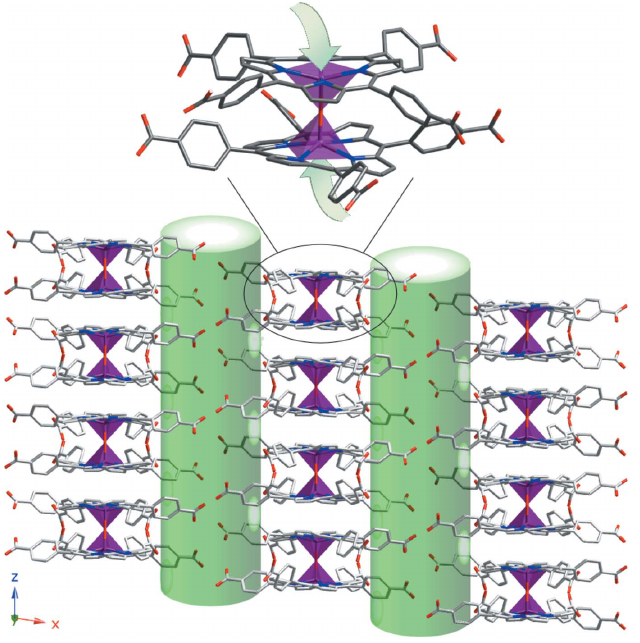
Figure 3 Representation of the accessibility of guest molecules to the active metal centres for compound 2 . Colour code: Fe purple, C grey, N blue and O red. Accessible pathways are represented by the green cylinders.